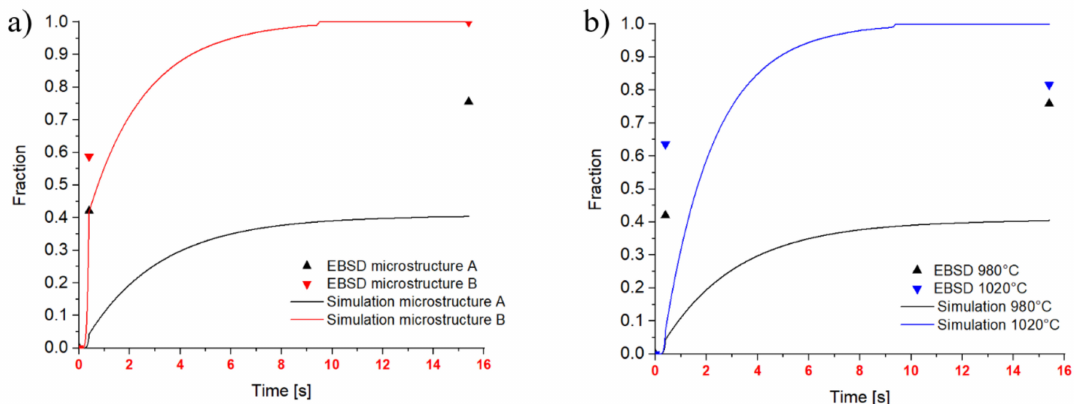
Figure 10. Recrystallized fraction over time including DRX and MDRX: ( a ) Comparison of microstructure A with microstruc- ture B: 980 ◦ C, strain rate 1 s − 1 , strain 0.54; ( b ) Comparison of 980 ◦ C and 1020 ◦ C on microstructure A: strain rate 1 s − 1 , strain